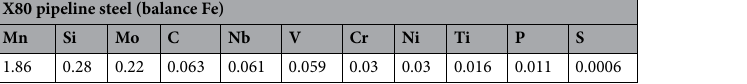
X80 pipeline steel (balance